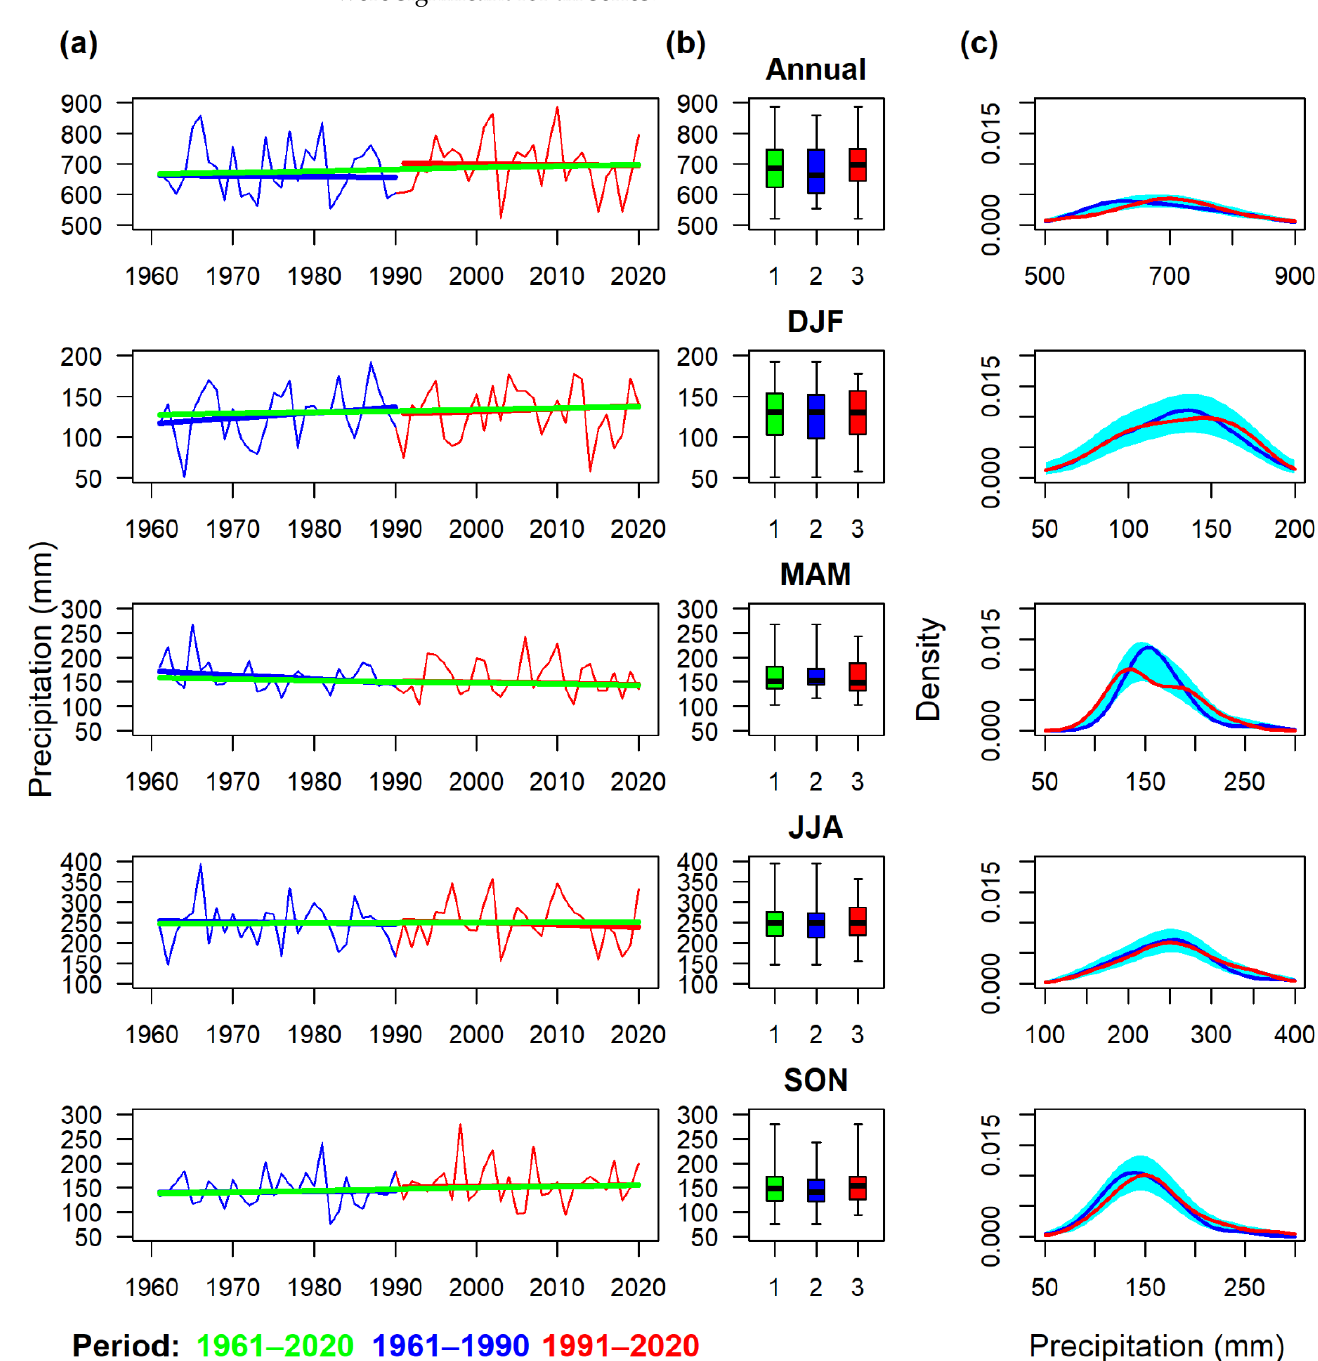
Figure 10. Annual and seasonal series of mean precipitation totals for the territory of the Czech Republic in the 1961 – 2020 period: ( a ) fluctuations with linear trends in the entire period, 1961 – 1990 and 1991 – 2020; ( b ) box plots (median, lower and upper quartile, minimum, and maximum) for 1961 – 2020 (1), 1961 – 1990 (2), and 1991 – 2020 (3); ( c ) the density distribution of the series in 1961 – 1990 and 1991 – 2020. The density curves outside the reference band (green – blue) indicate a significant difference in the two distributions (and vice versa).